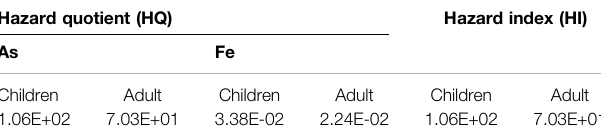
TABLE 4 | Health risk assessment of children and